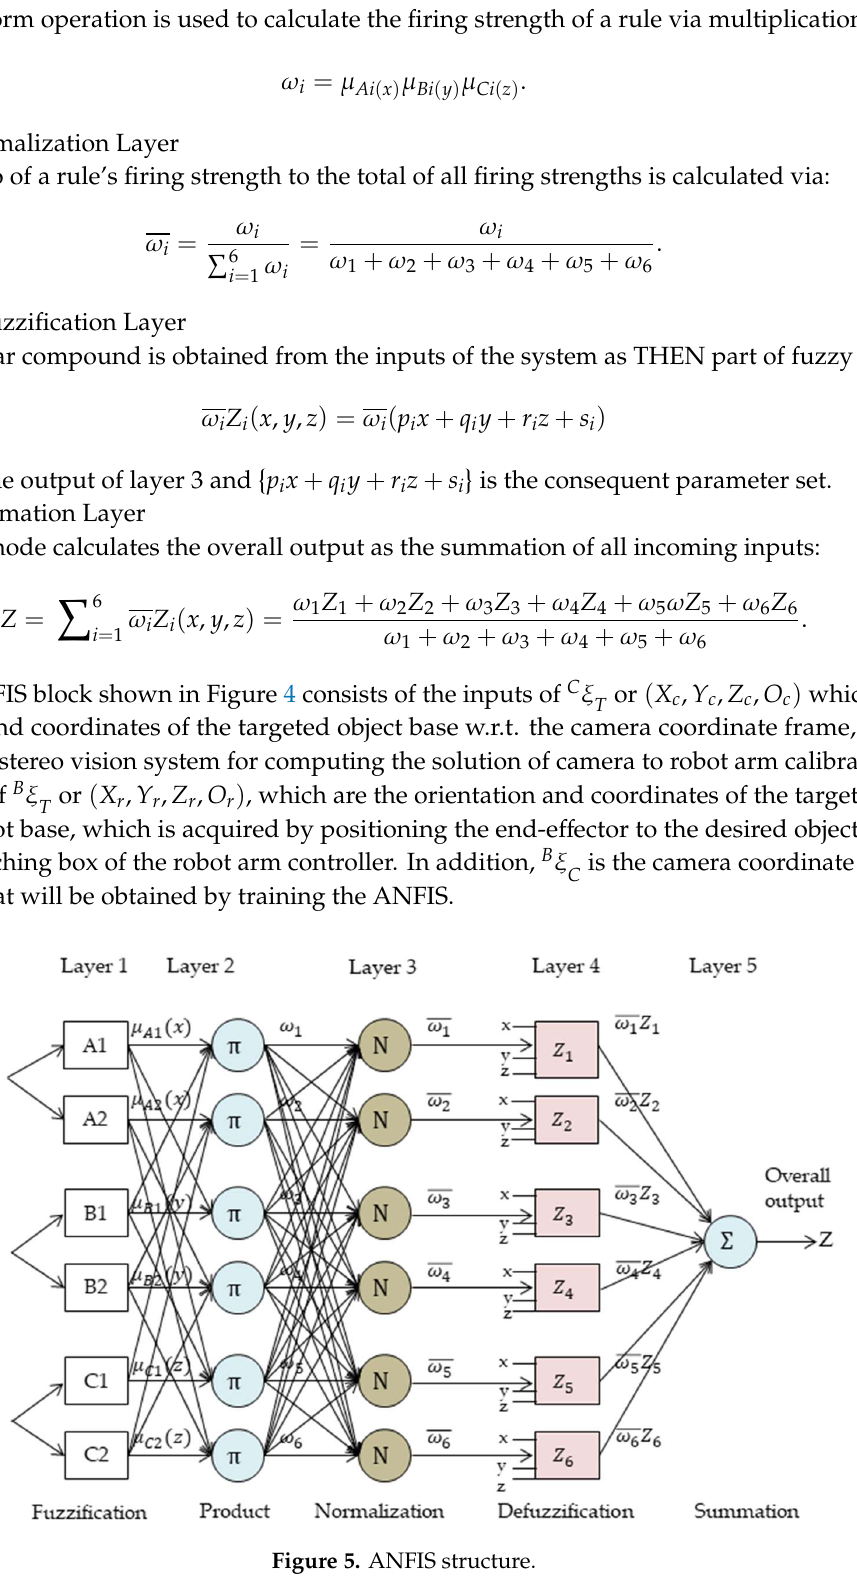
Figure 5. ANFIS structure.